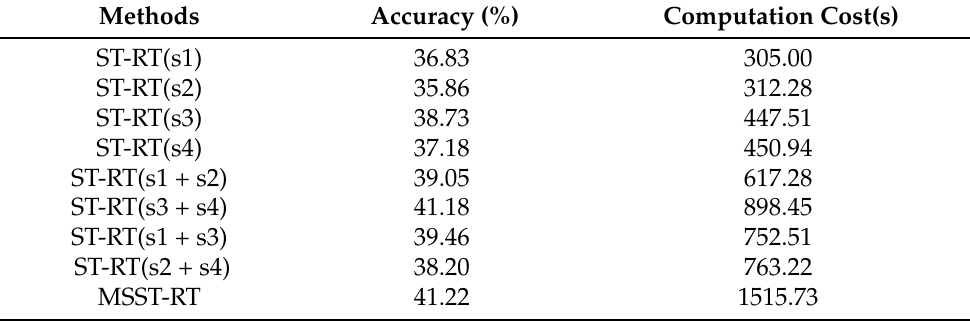
Table 8. The effect of number of streams in the ST-RT Model on UAV-Human. “s1” is the stream with 10 frames, joint frames, “s2” is the stream with 10 frames, bone frames, “s1” is the stream with 20 frames, joint frames, “s1” is the stream with 20 frames, bone frames. Furthermore, “ST-RT(X + Y)” is the fusion of the model with X stream and the model with Y stream. “Computation cost” means average second per epoch on the train